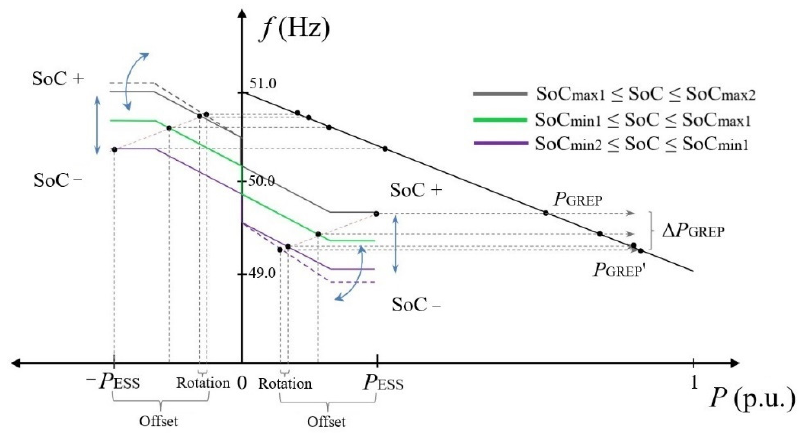
Figure 12. Segmented steady-state characteristic of the ESS.